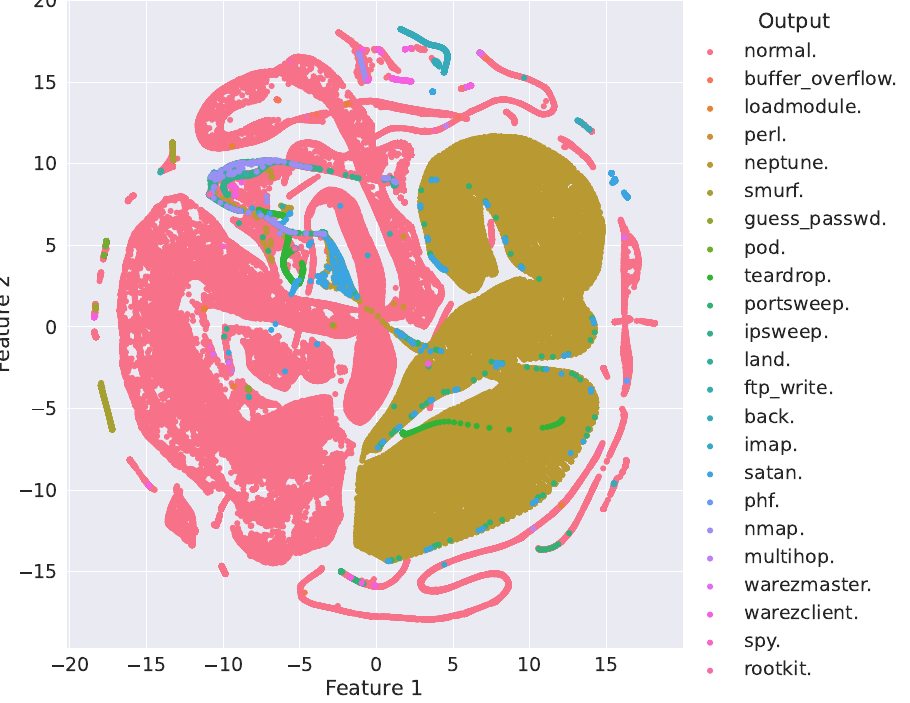
Figure 8. t-SNE plot with 100 perplexity and 500 iteration levels.